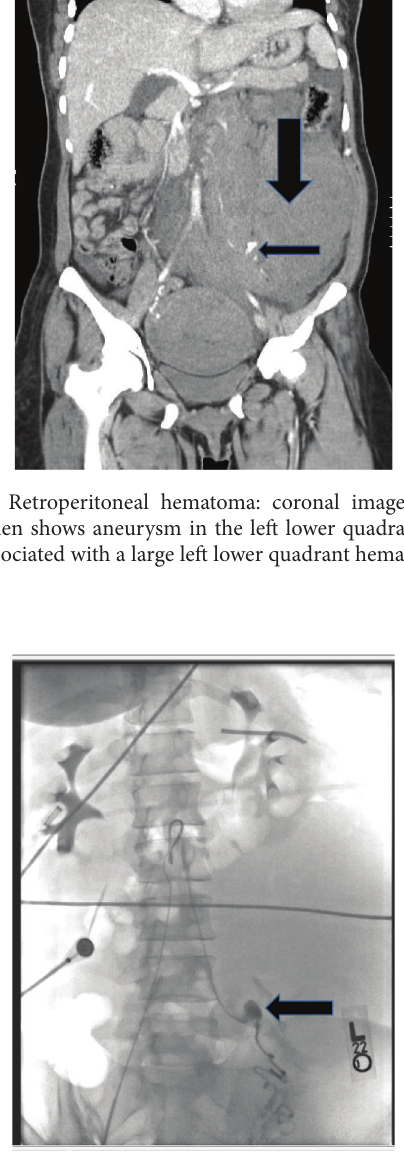
Figure 3: Left ovarian artery aneurysm: selective left ovarian arteriogram demonstrates an ovarian artery aneurysm